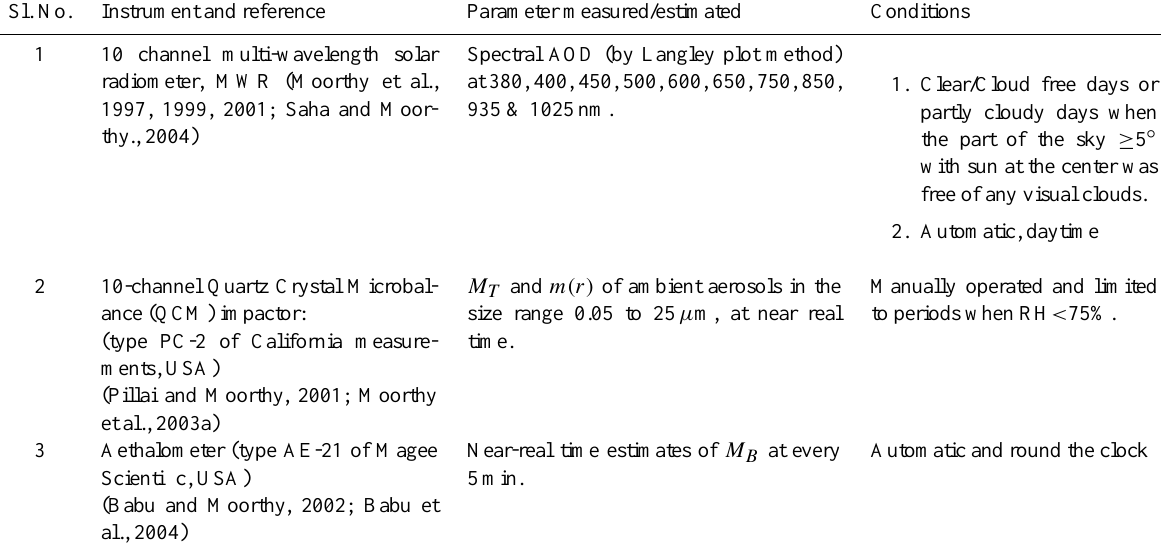
Table 1. Instrument details and parameters obtained. Sl.